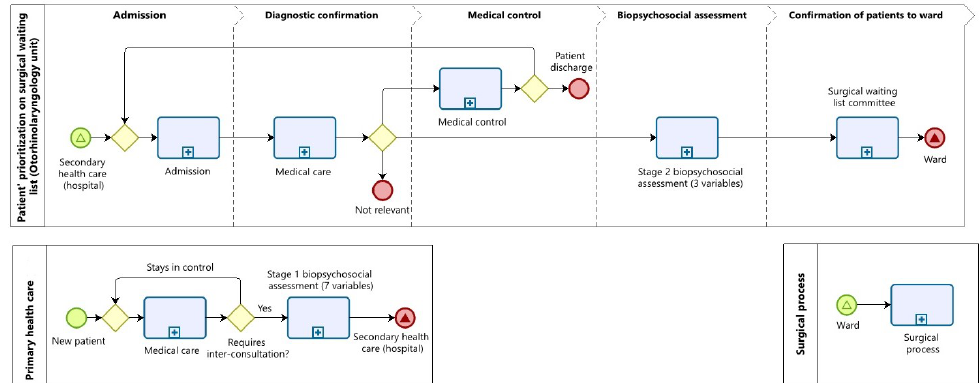
Figure 11. Prioritization process based on the proposed networking strategy,